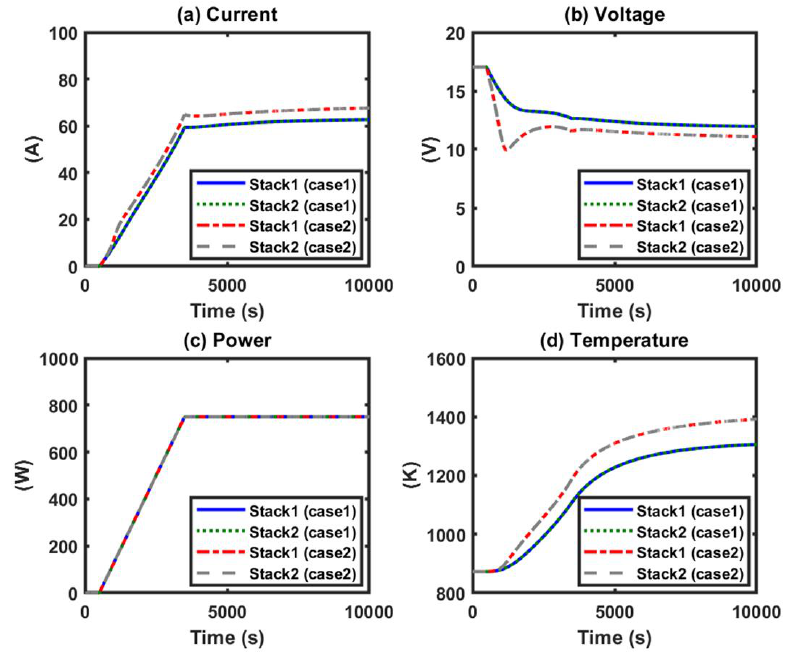
Figure 4. Transient response of the SOFC system obtained when the two employed stacks are the same. The total requested power was 1500 W. Case 1: stacks have a small ohmic loss. Case 2: stacks have a large ohmic loss. ( a ) Stack output current, ( b ) stack voltage, ( c ) stack output power, and ( d ) stack temperature.